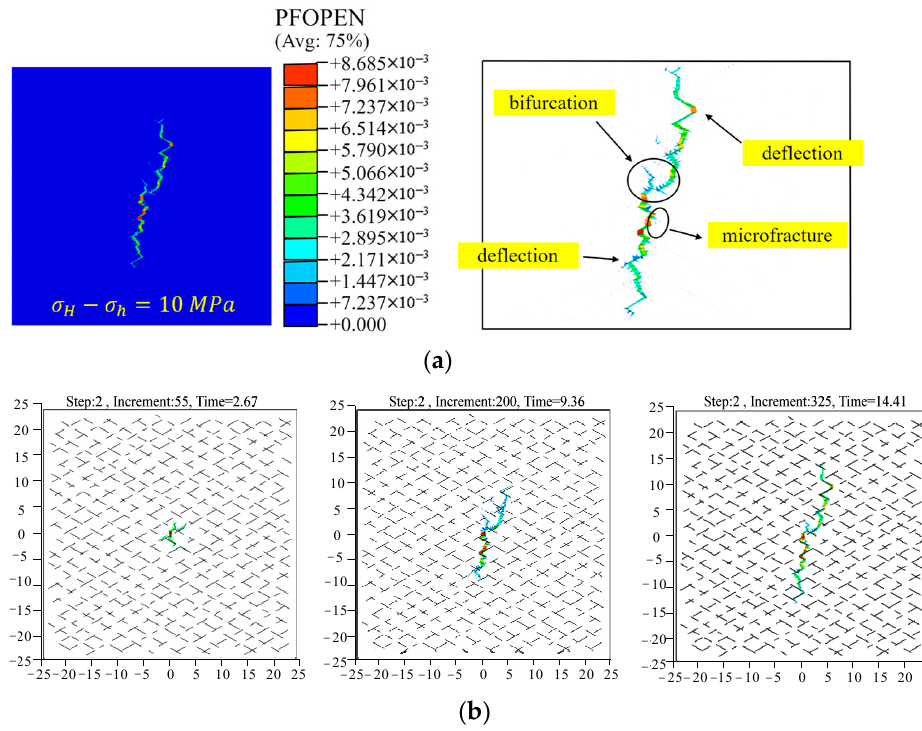
Figure 11. The in situ stress difference at 10 MPa. ( a ) Schematic diagram of the fracture morphology. ( b ) The propagation process of the hydrofractures in a natural fracture network.